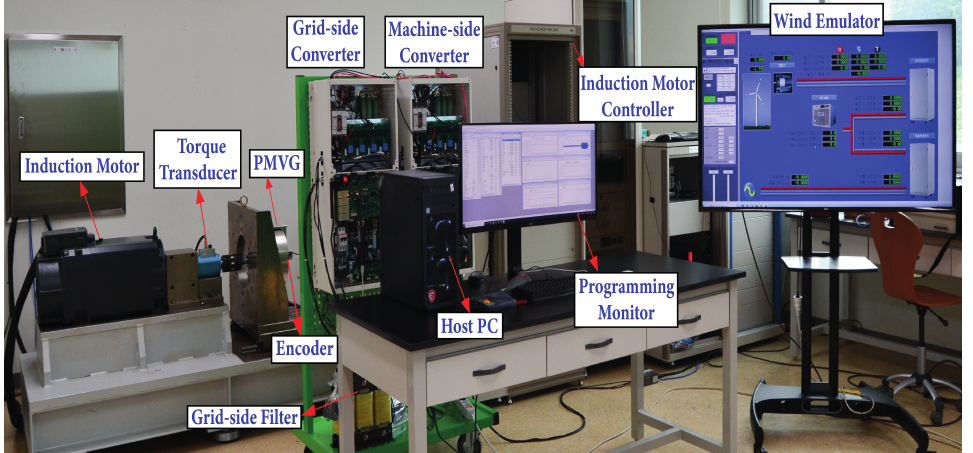
Figure 7. 5-kW PMVG-based experimental system